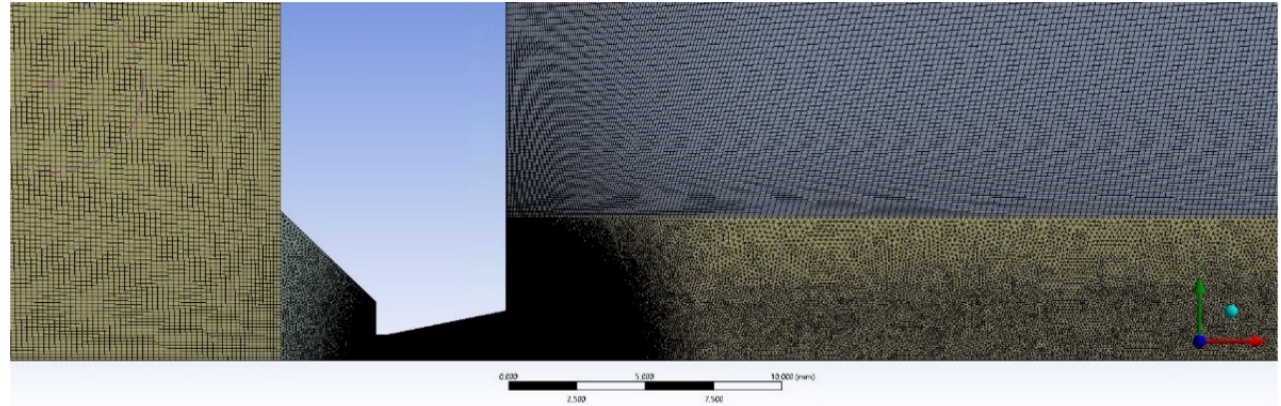
Figure 13. Mesh at the beginning of the calculation.